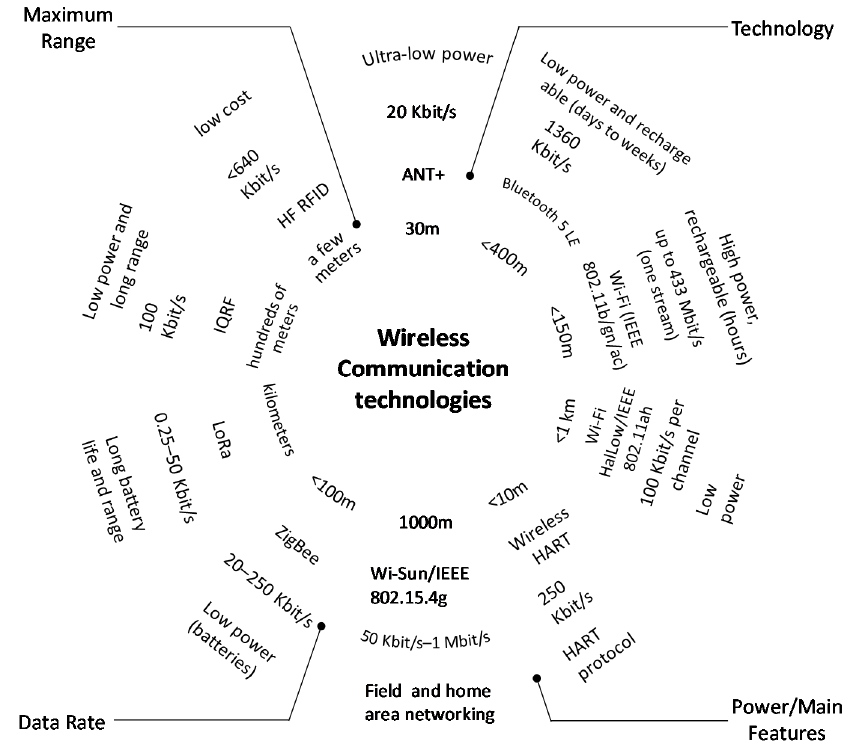
Figure 7. Summary of wireless communications technologies for smart clothing (information from